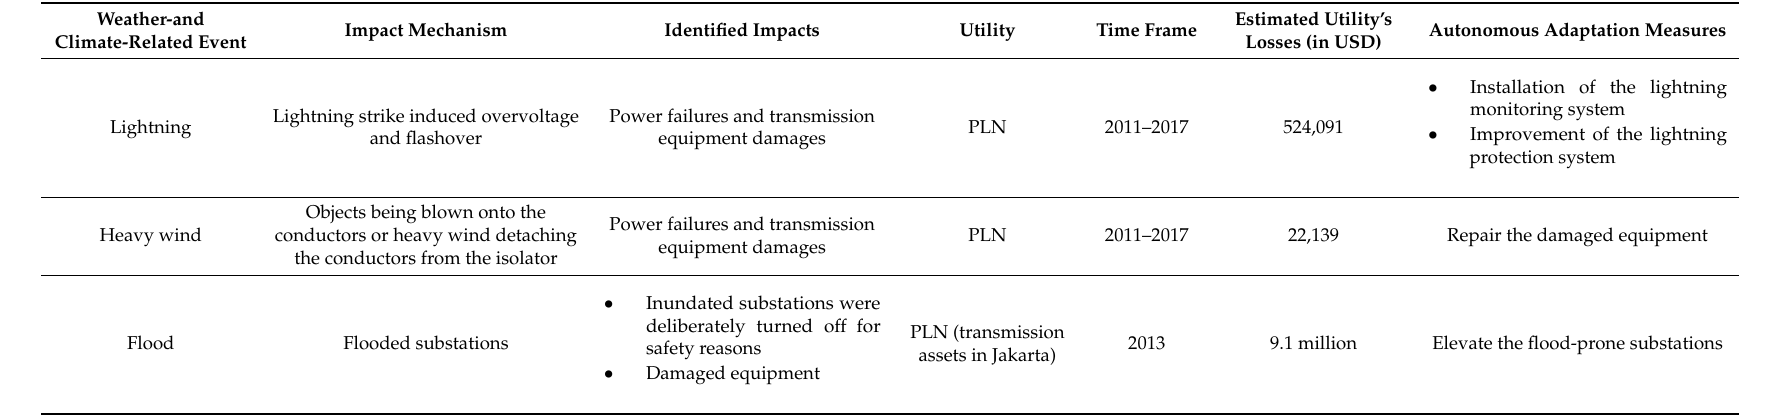
Table 5. Impacts of severe weather events on transmission networks and the utility’s autonomous adaptation responses. Source: own